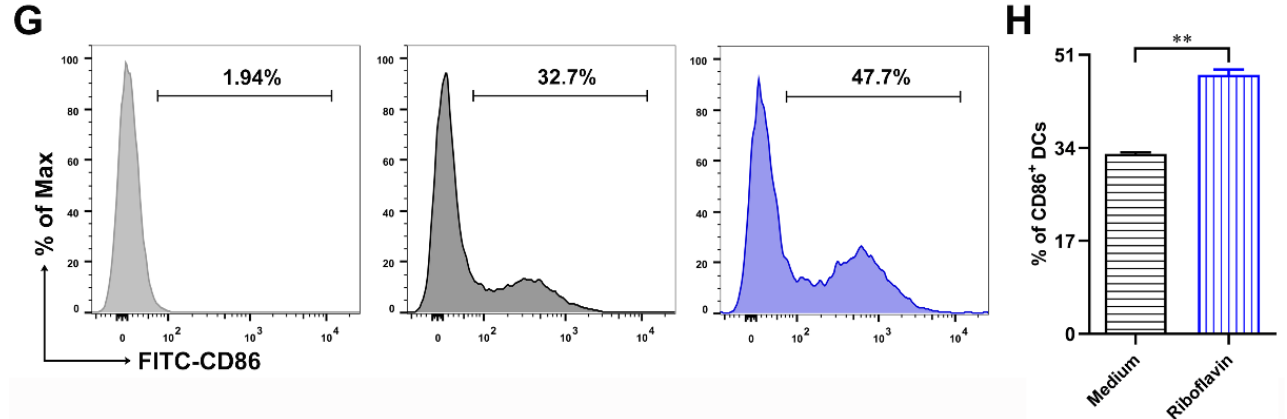
Figure 4. Riboflavin promotes the expression of MHCII, CD40, CD80, and CD86 in DCs. DCs were stimulated with riboflavin (40 µ M) for 24 h. The expression of MHCII ( A ), CD40 ( C ), CD80 ( E ), and CD86 ( G ) was detected via FCM. ( B , D , F , H ) The percentage values are presented as the mean ± SD. Results are from one representative experiment out of three performed. Unpaired Student’s two-sided t -tests were employed to determine the differences between the two groups; * p < 0.05, ** p < 0.01.